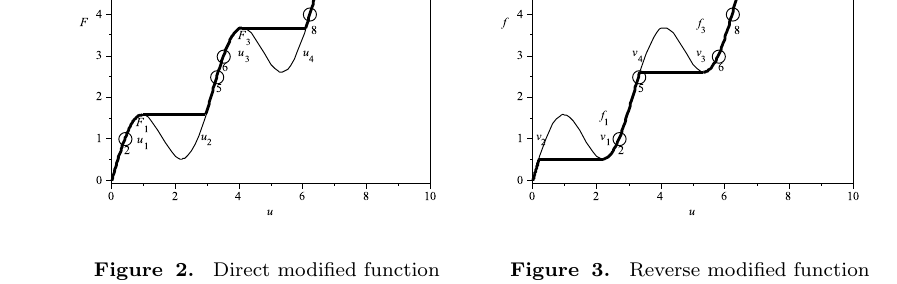
Figure 2. Direct modified function F ( u ) at Bm = 1 . 5. The following numerical values are shown in figure: u 1 = 0 . 9553, u 2 = 2 . 9448, u 3 = 4 . 0969, u 4 = 6 . 0864, u 5 = 7 . 2385, u 6 = 9 . 2280, F 1 = 1 . 5797, F 3 = 3 . 6741, F 5 = 5 . 7685, F (cid:48) (0) = 2 . 6667 . In the fixed points (cid:74) there are values of ωτ with the coordinates ( β s (1) ,ωτ/ 2) .